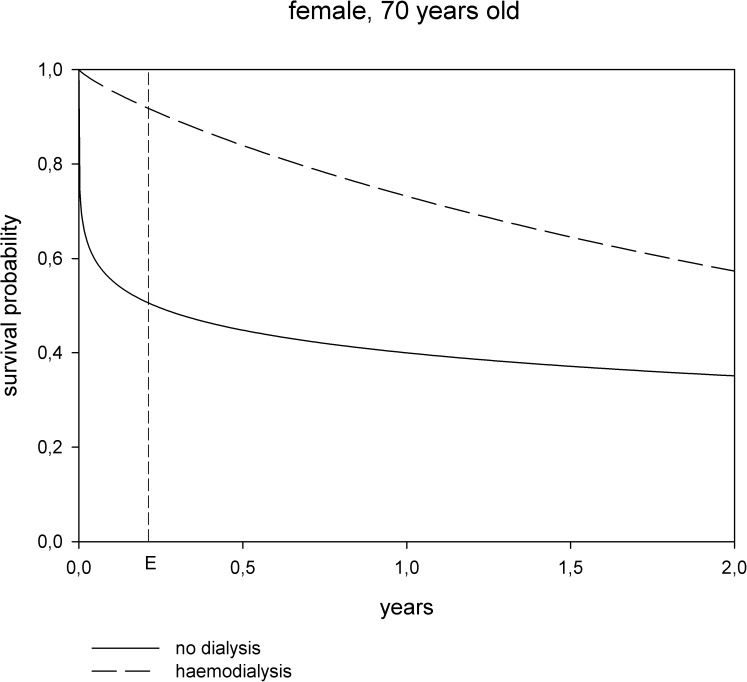
Survival probability modeled by Weibull distribution and stratified by treatment.Dialysis treatment vs. conservative management for a female patient aged 70 years. E marks the time to equal risk (the slopes of the two survival curves are the same).